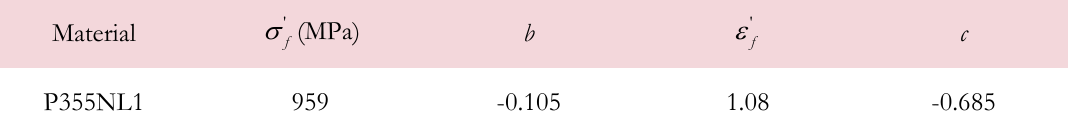
Table 3: Morrow constants for the P355NL1 calculated as per Eqs. (4)-(7).